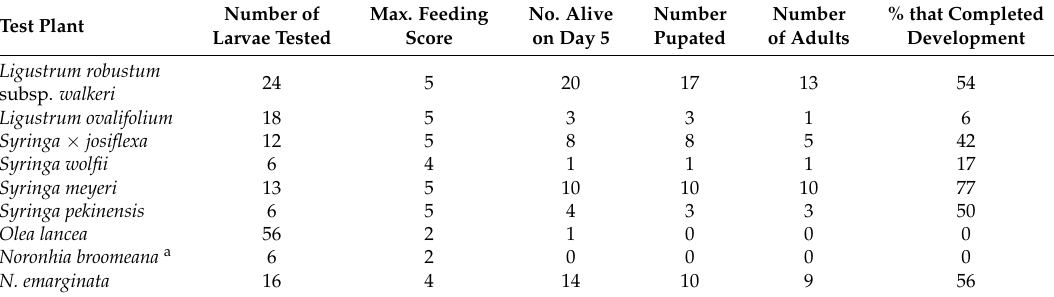
Table 3. Feeding scores, survival and development of first instar Epiplema albida larvae in no-choice feeding tests and subsequent larval development